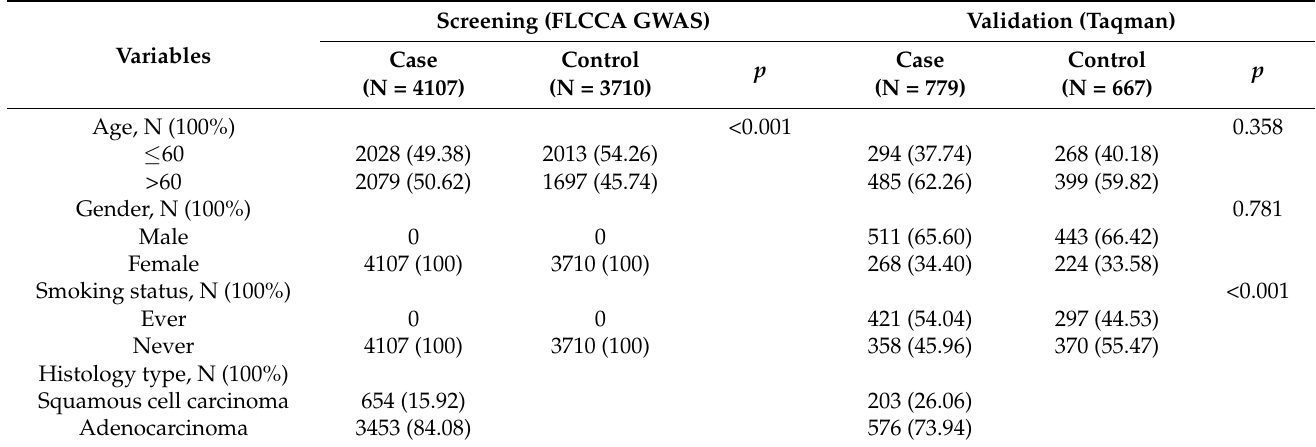
Table 1. Characteristics of the subjects enrolled in this study.